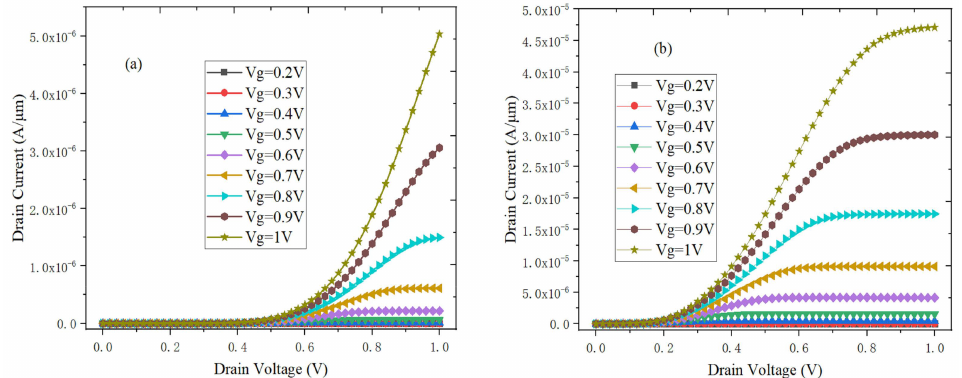
Figure 3. The output characteristics of ( a ) DLTFET, ( b )